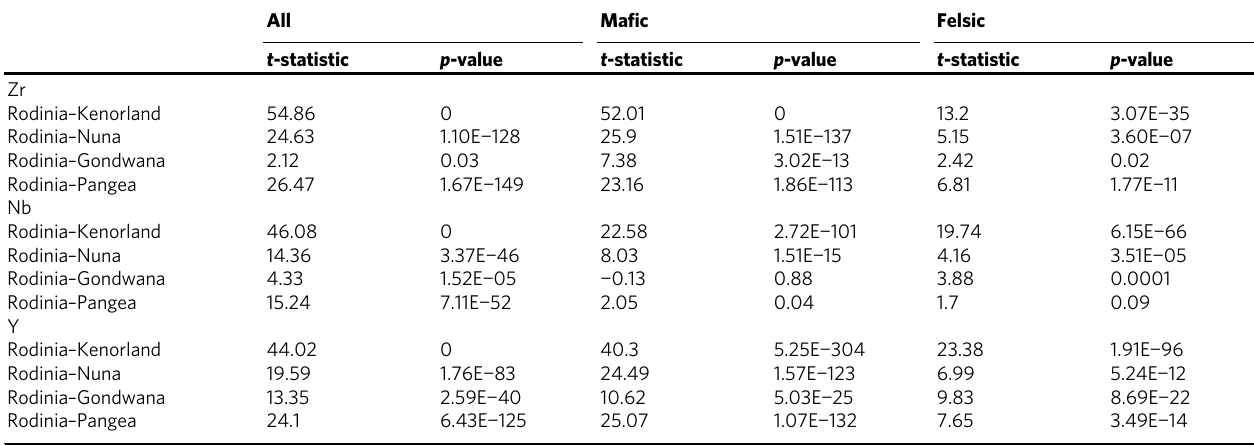
Table 1 Results of two-sample Welch ’ s t -tests of Zr, Nb, and Y concentrations between igneous rocks formed during Rodinian assembly and those formed during assemblies of other supercontinents All